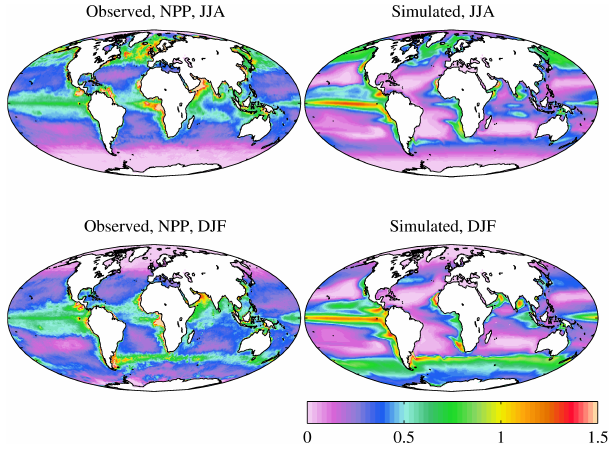
Fig. 12. Hovm¨oller diagrams of observational (SeaWiFS ; left) and simulated (right) monthly surface chlorophyll, averaged zonally for the Atlantic (top) and Pacific (bottom) basins. Concentrations in mg chl. m − 3 . Fig. 12. Observational (left) and simulated (right) integrated pri- Fig. 13. Observational ( left ) and simulated ( right ) integrated primary production for northern summer (June–July– August; top ) and northern winter (December–January–February; bottom ). The observational field shown here is an mary production for northern summer (June-July-August; top) and average of the VGPM, Eppley–VGPM and CbPM estimates. Production in g C m − 2 d − 1 . northern winter (December-January-February; bottom). The obser- vational field shown here is an average of the VGPM, Eppley- VGPM and CbPM estimates. Production in gCm − 2 d − 1